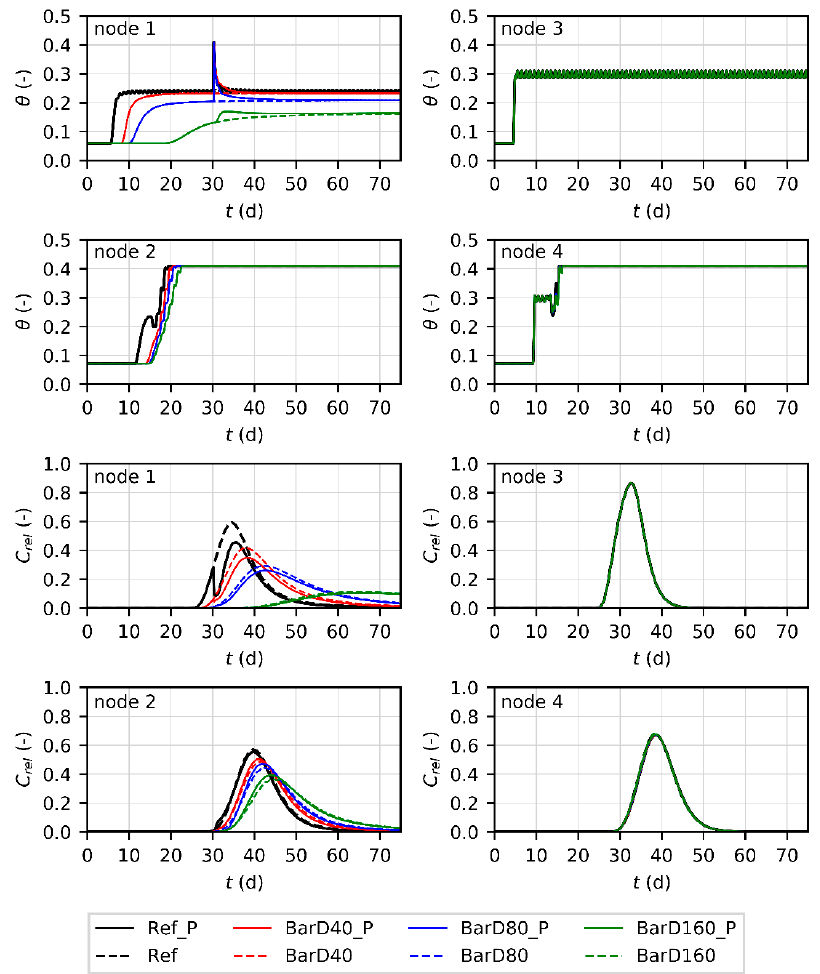
Figure 5. Simulated values of water content θ and relative solute concentration C rel at four selected observation nodes (as depicted in Figures 2 and 3) for the reference scenario and the scenarios BarD40, BarD80 and BarD160 (with different distances between TSE and precipitation infiltration ditch). _P indicates the scenarios with a precipitation event.